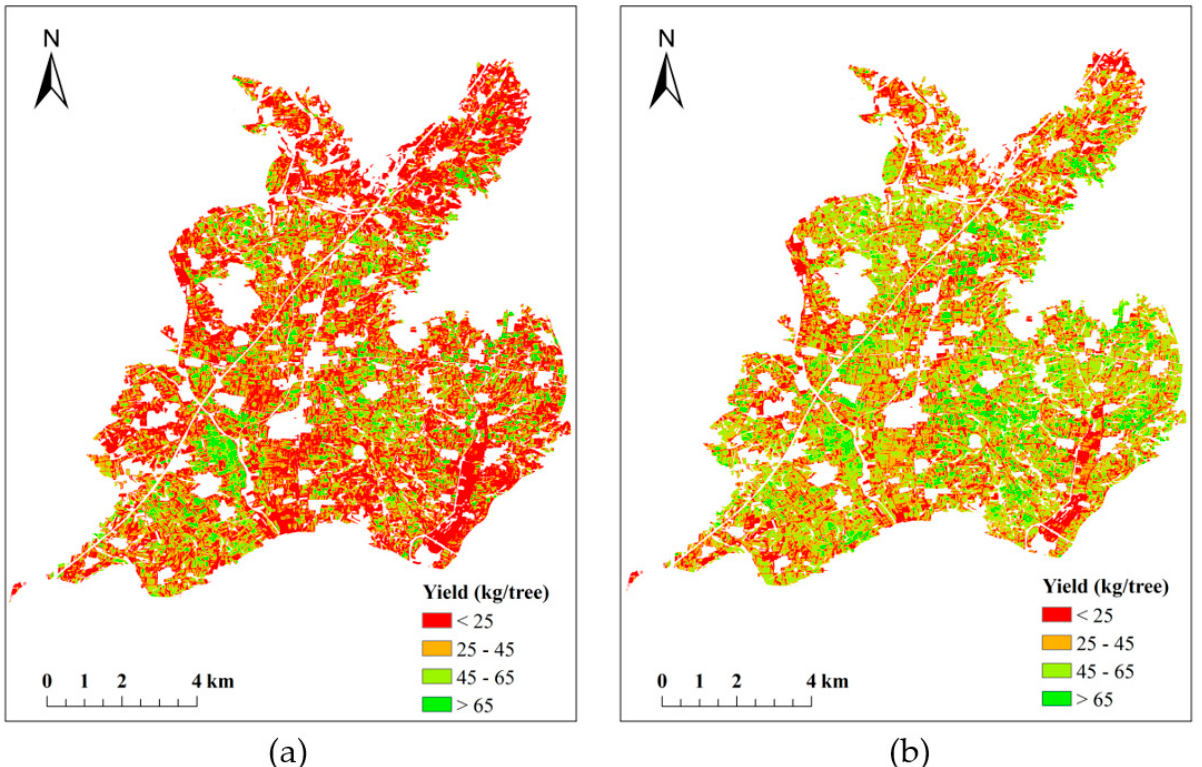
Figure 9. Classified yield maps derived from the RF ∑ NDVI model for Guanli town in ( a ) 2019 and ( b ) 2020.